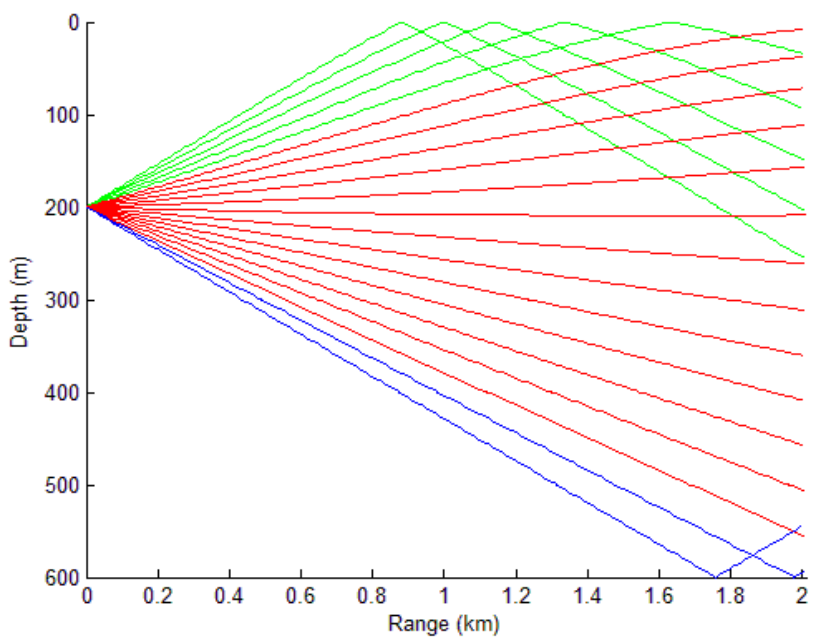
Figure 12. The underwater acoustic signal propagation.